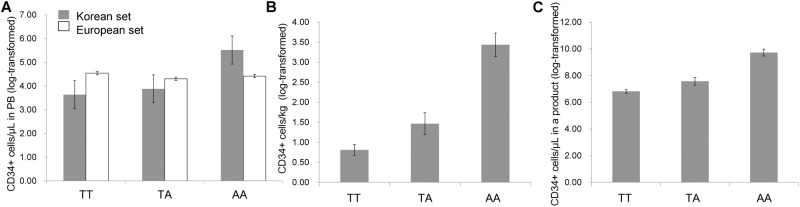
Correlations between rs11264422 genotype and continuous outcomes.There were significant associations between rs11264422 genotype and (A) circulating CD34+ cells/μL (raw P = 0.03), (B) total CD34+ cells/kg (raw P = 0.008), and (C) product CD34+ cells/μL (raw P = 0.003) in the Korean set (gray-colored bar). However, no statistically significant association was found between rs11264422 genotype and circulating CD34+ cells/μL in the European set (solid-lined bar). Mobilization outcomes were applied natural log transformation, due to the skewed distribution.